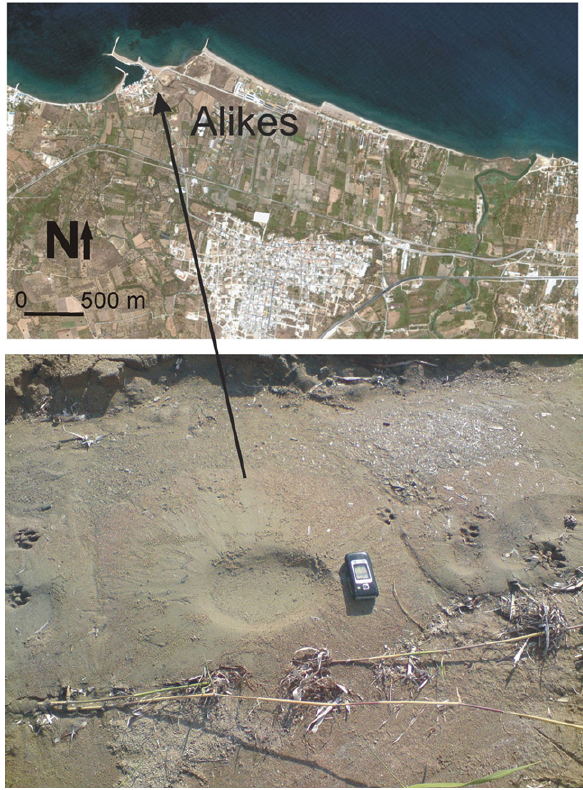
Figure 7 (left, top to bottom). Liquefaction manifestations at the sea shore of the village Kato Achaia. (a) General view of the area; (b,c,d) examples of vent fractures with 12, 20 and 30 cm-width, respectively; (e) formation of a 4 m-long vent fracture. Figure 8 (above, top to bottom).Map showing the location of lique- faction-induced ground disruption sites in the area of Alikes. Exam- ple of sand crater with a diameter of 15 cm formed at the site